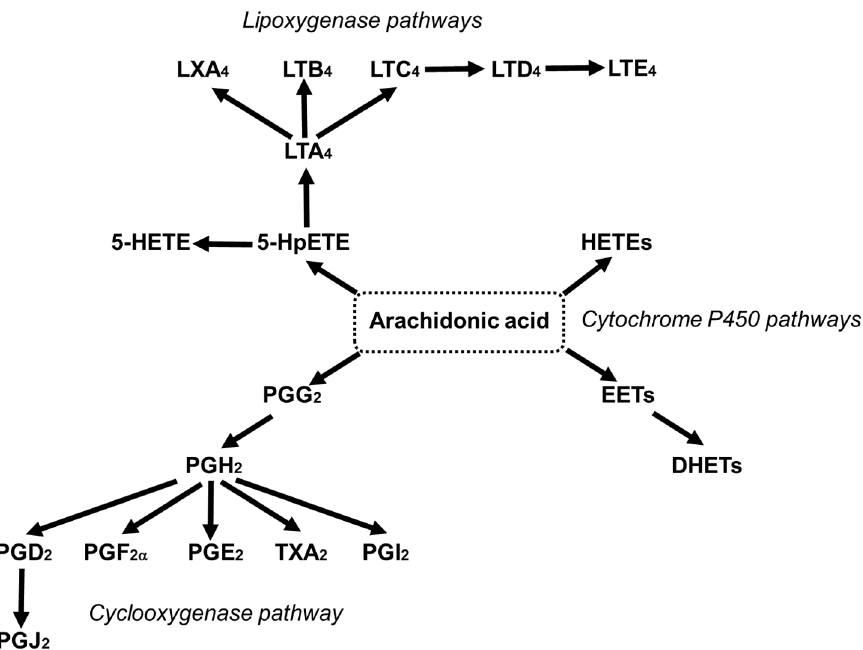
Figure 4. Overview of the cyclooxygenase, lipoxygenase and cytochrome P450 pathways of conver- sion of arachidonic acid to bioactive mediators. DHET, dihydroxyeicosatrienoic acid; EET, epoxye- icosatrienoc acid; HETE, hydroxyeicosatetraenoic acid; HpETE, hydroperoxyeicosatetraenoic acid; LX, lipoxin; LT, leukotriene; PG, prostaglandin; TX, thromboxane.